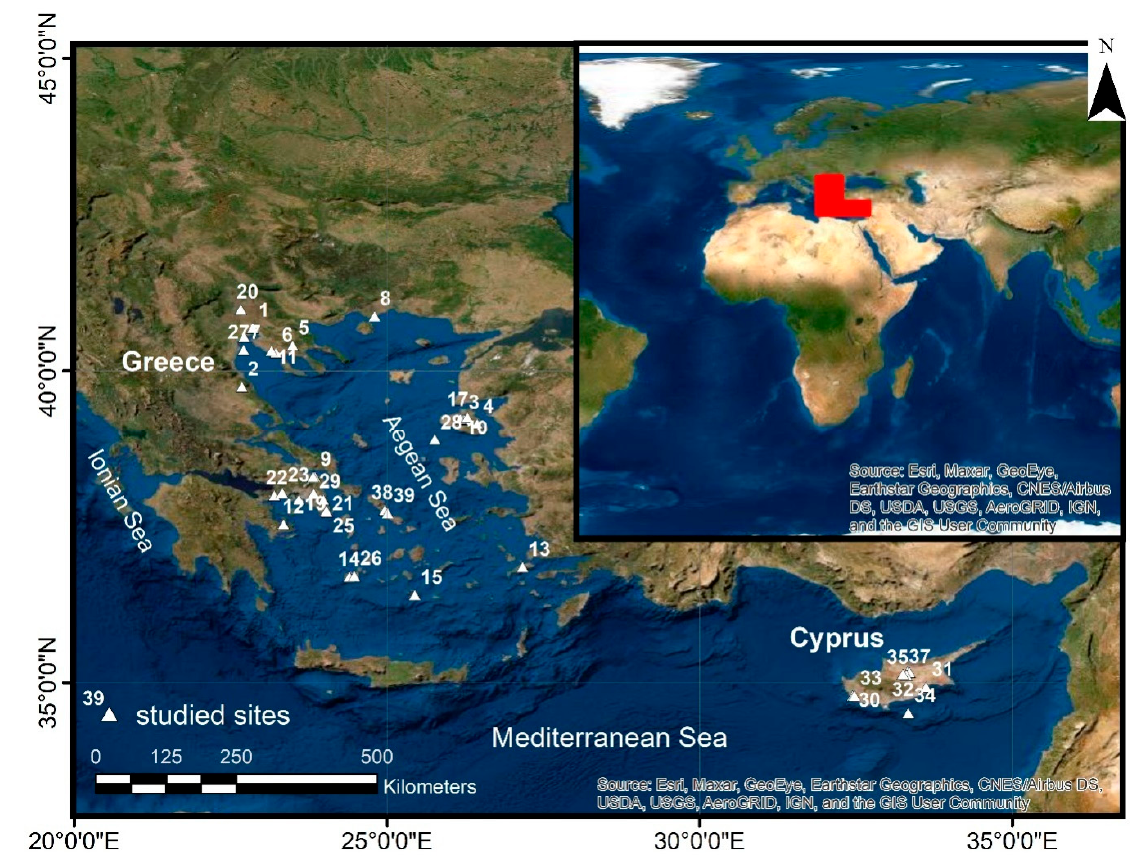
Figure 2. Map of Greece and Cyprus showing the studied sites (modified from [56]). More information and details about each site are tabulated in Table 2.